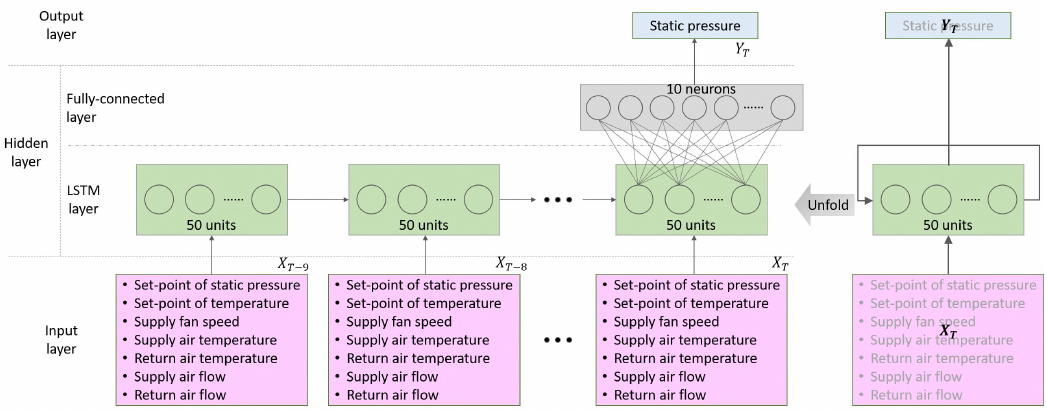
Figure 9. Deep learning structure for forecasting static pressure in ducts.